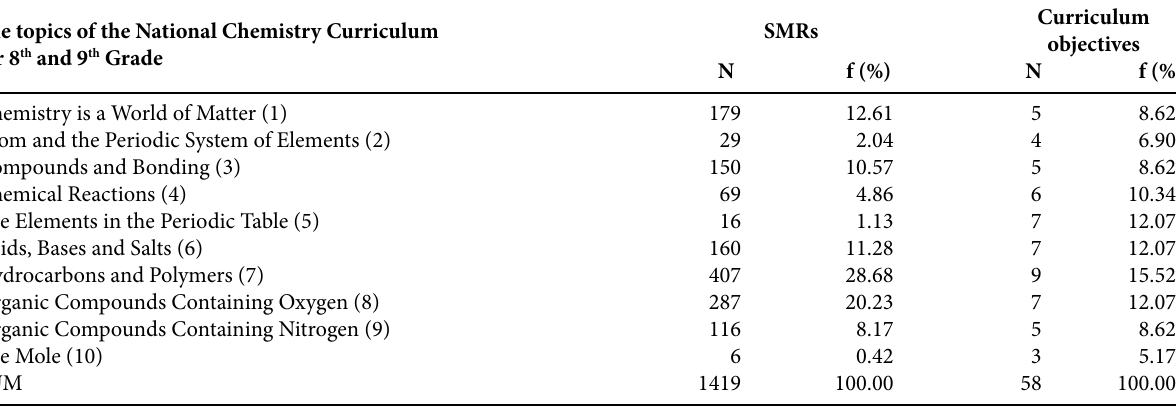
Table 3. The proportion of SMRs and curriculum objectives in the particular topics of the textbook sets The topics of the National Chemistry